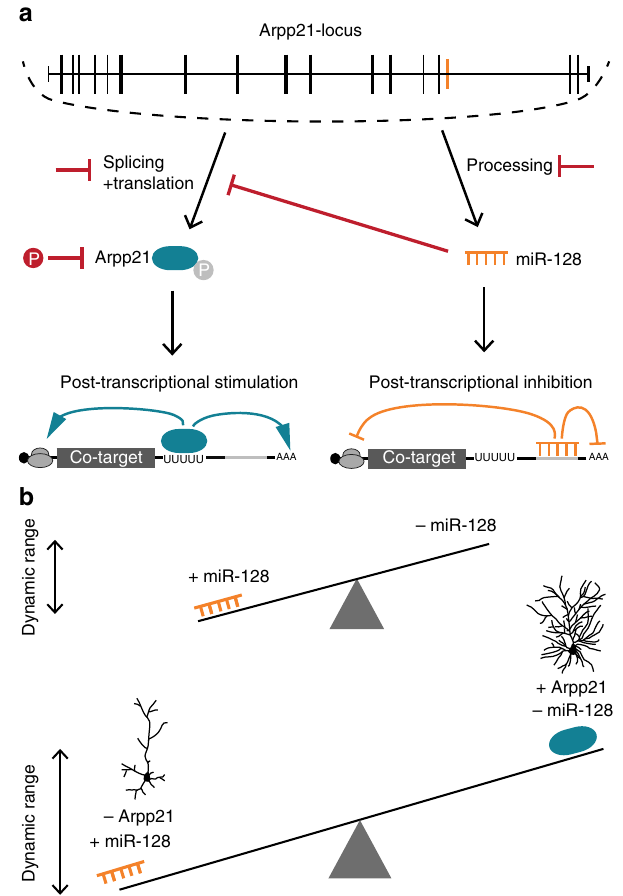
Fig. 8 Schematic depiction of our model for the miR-128-ARPP21 regulatory circuit and its impact on the post-transcriptional regulation of common mRNA targets. a ARPP21 and miR-128 are co-expressed from the same genetic locus. pri-miR-128-2 is generated upon Arpp21 transcription and subsequently processed by Drosha and Dicer into mature miR-128. miR- 128-loaded miRISC binds and downregulates target mRNAs that possess the miR-128 seed match sequence. Arpp21 is transcribed, spliced, and translated into protein. ARPP21 binds a subset of miR-128 target mRNAs via a uridine-rich sequence motif leading to increased protein expression. Mechanisms that could potentially regulate the relative activities of ARPP21 and miR-128 are marked in red. Alternative splicing of the Arpp21 mRNA and phosphorylation of ARPP21 protein could regulate its activity. Further, miR-128 can inhibit Arpp21 expression through a conserved seed match in the Arpp21 3 ′ UTR. On the other hand, miR-128 processing is regulated during development. b Co-regulated transcripts have a greater dynamic range of gene expression compared to transcripts under control of either miR-128 or ARPP21 acting on their own. Dendritic complexity of cortical neurons is highly sensitive to the relative levels of miR-128 and